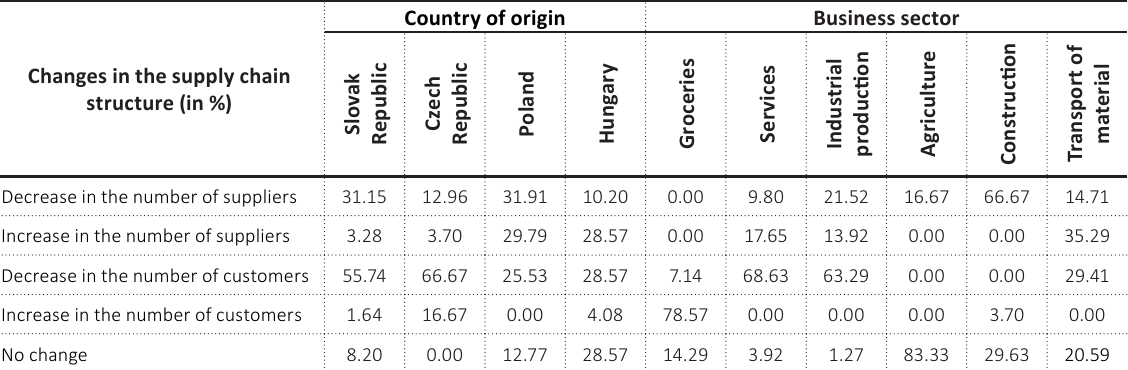
Table 3. Changes in the number of supply chain nodes